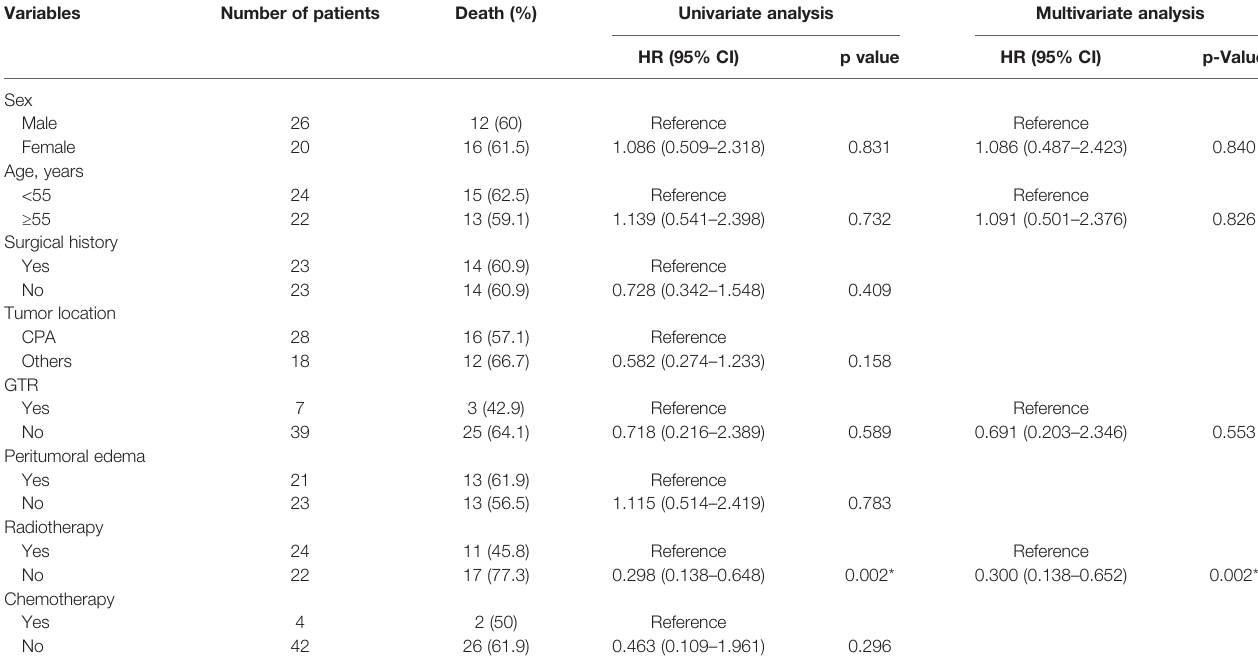
TABLE 4 | Cox regression model for risk factors predicting